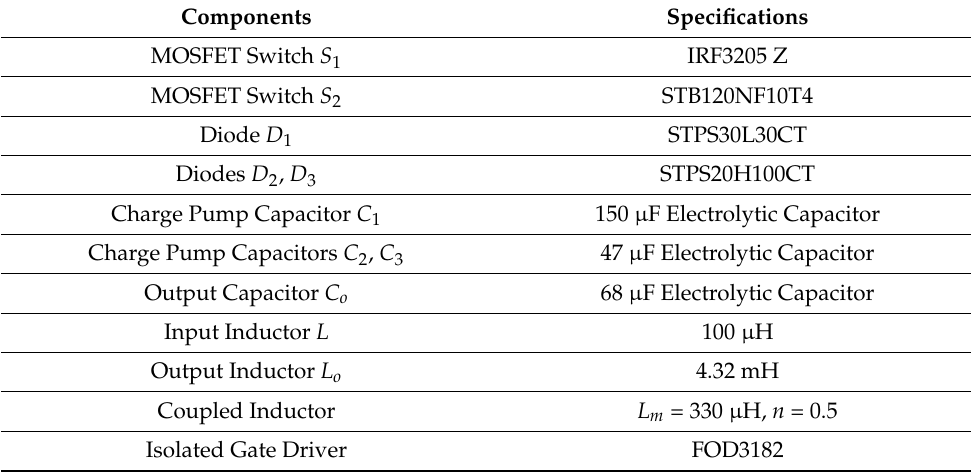
Table 4. Component specifications used in the isolated MISOC.